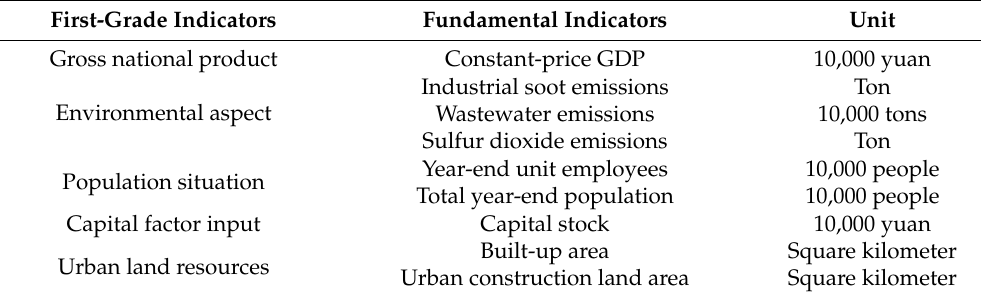
Table 1. The evaluation index system for